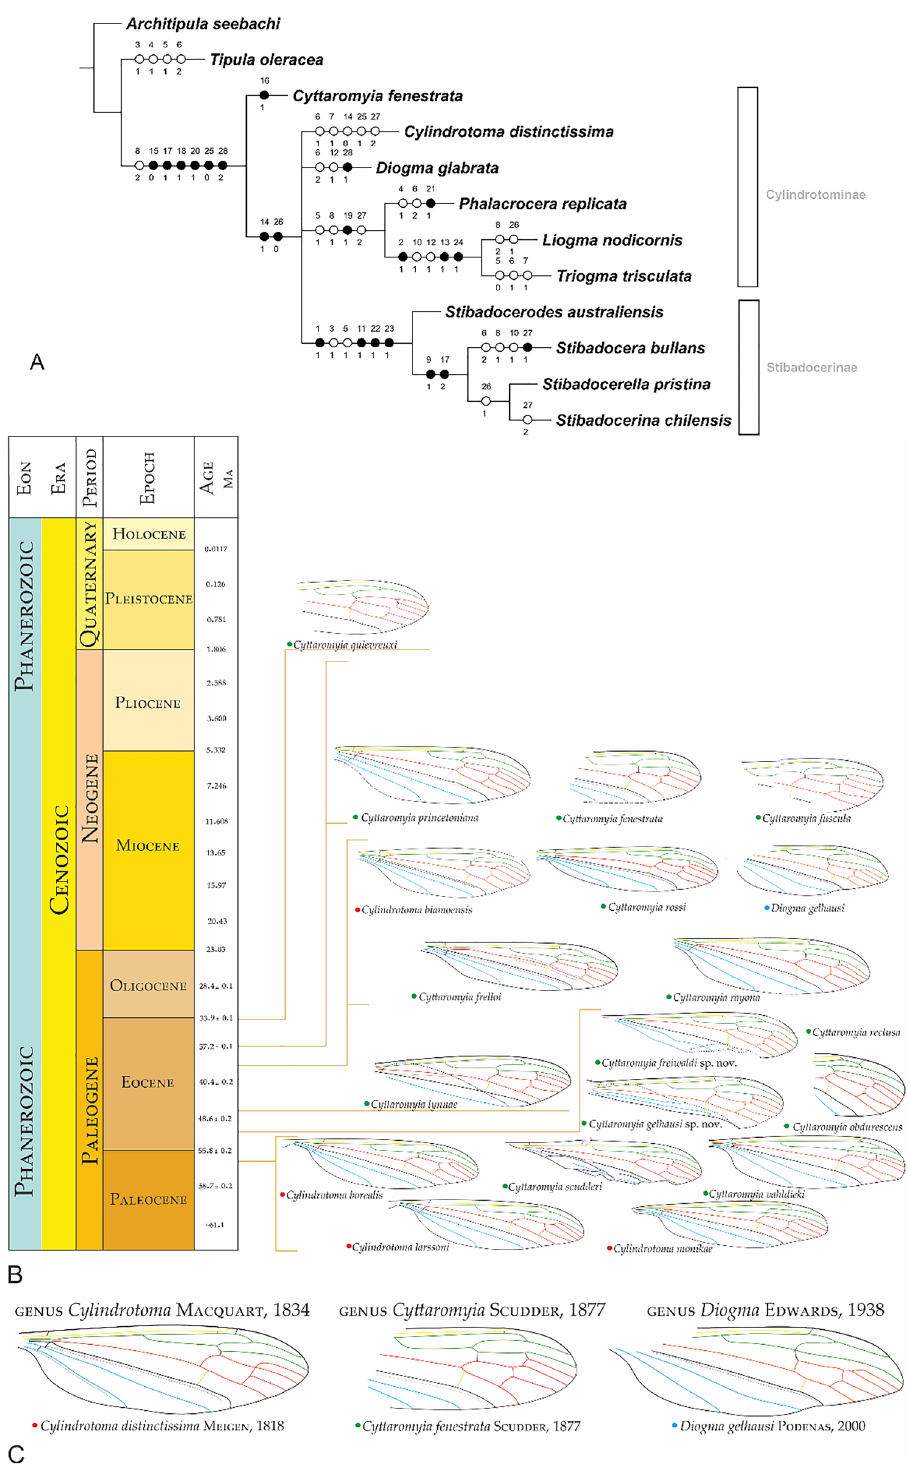
Figure 6. ( A ) Consensus relationships tree of genera of subfamily Cylindrotominae. Filled circles indicate synapomorphies or autapomorphies; open circles indicate plesiomorphies. Number of character given above circles, states of characters below circles; ( B ) Wing venation of fossil Cylindrotominae with chronostratigraphic distribution view; ( C ) Wing venations of representatives of genera: Cylindrotoma , Cyttaromyia , Diogma , represented in fossil record. Wing venation redrawing 24,25,27–29,31,34,42,50 . Stratigraphic chart according to International Stratigraphic Chart, International Commission of Stratigraphy (v. 2021/05) https:// strat igrap hy. org/